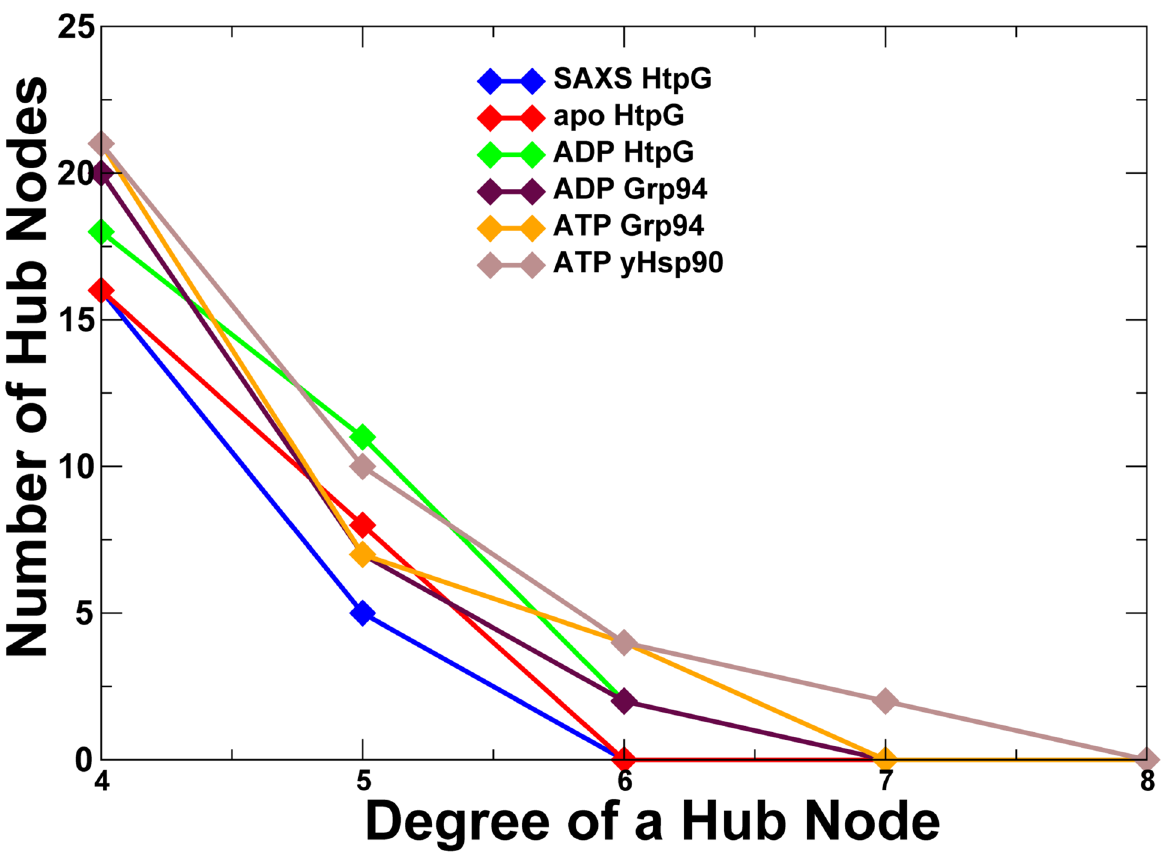
Figure 9. The Degree Distribution of Residue Hubs in the Hsp90 Structures. The number of hub nodes as a function of the degree of a hub is shown for the solution HtpG structure (in blue); the apo-HtpG structure (in red); the ADP-HtpG structure (in green); the ADP-Grp94 structure (in maroon); the ATP-Grp94 structure (in orange); and the yeast ATP-Hsp90 structure (in brown). The coloring annotation of the distribution is consistent with the annotation of residue hubs in Figure